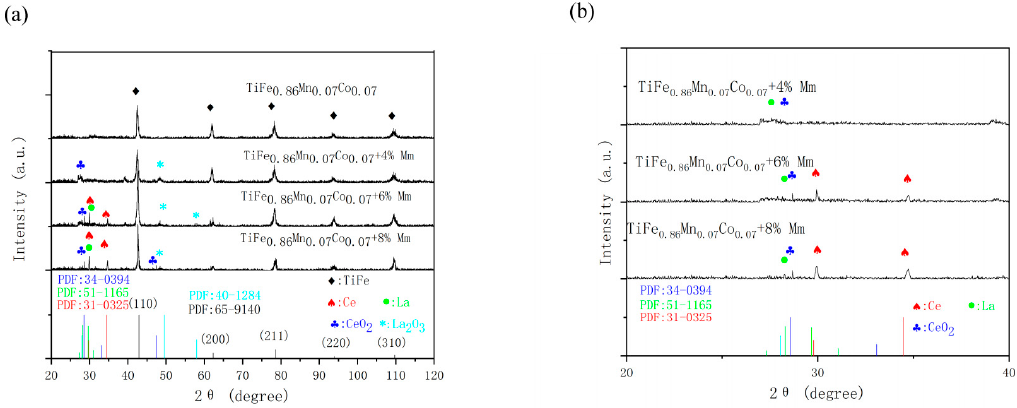
Figure 1. XRD patterns of TiFe 0.86 Mn 0.07 Co 0.07 + x% Mm (x = 0,4,6,8) alloys. ( a ) 20~120 degree; ( b ) 20~40 degree.